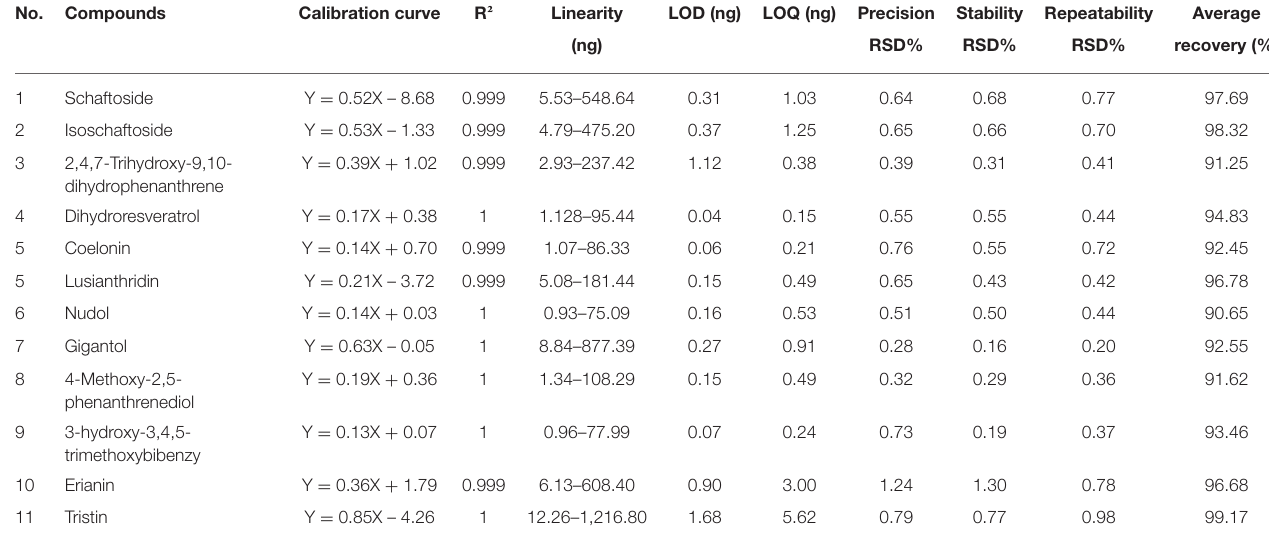
TABLE 4 | Calibration curves, linearity, limits of detection (LODs), and limits of quantification (LOQs) of the method used for assessing the 11 analytes. No. Compounds